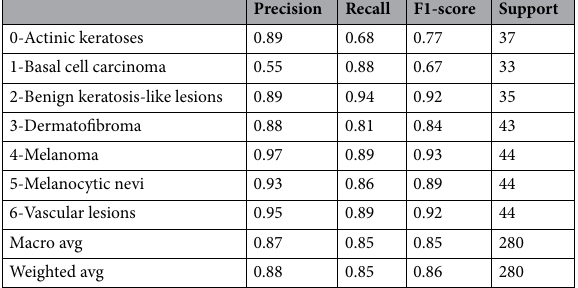
Table 7. Multi-class classification report of the customised CNN